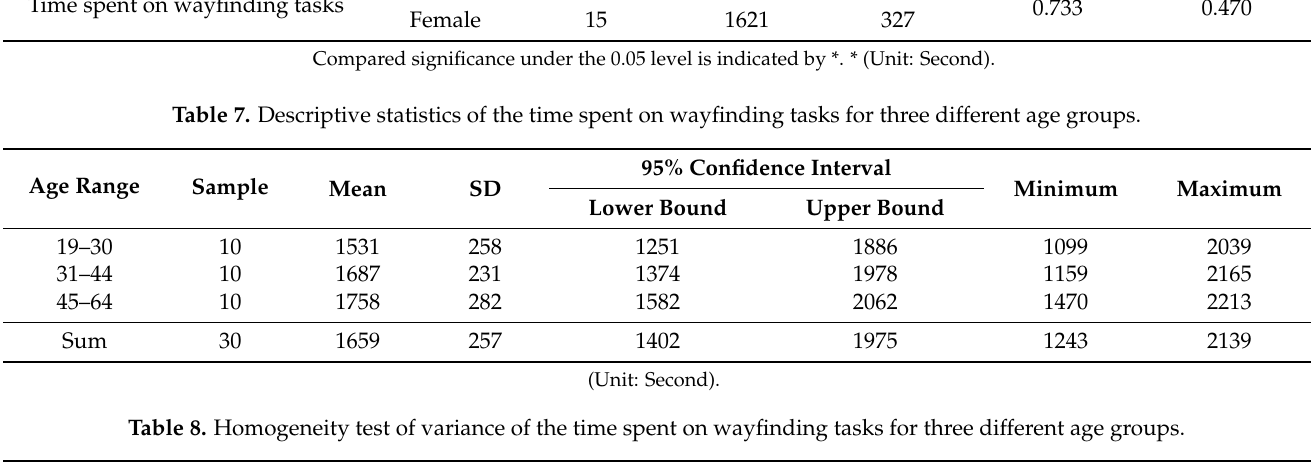
Time spent on wayfinding tasks